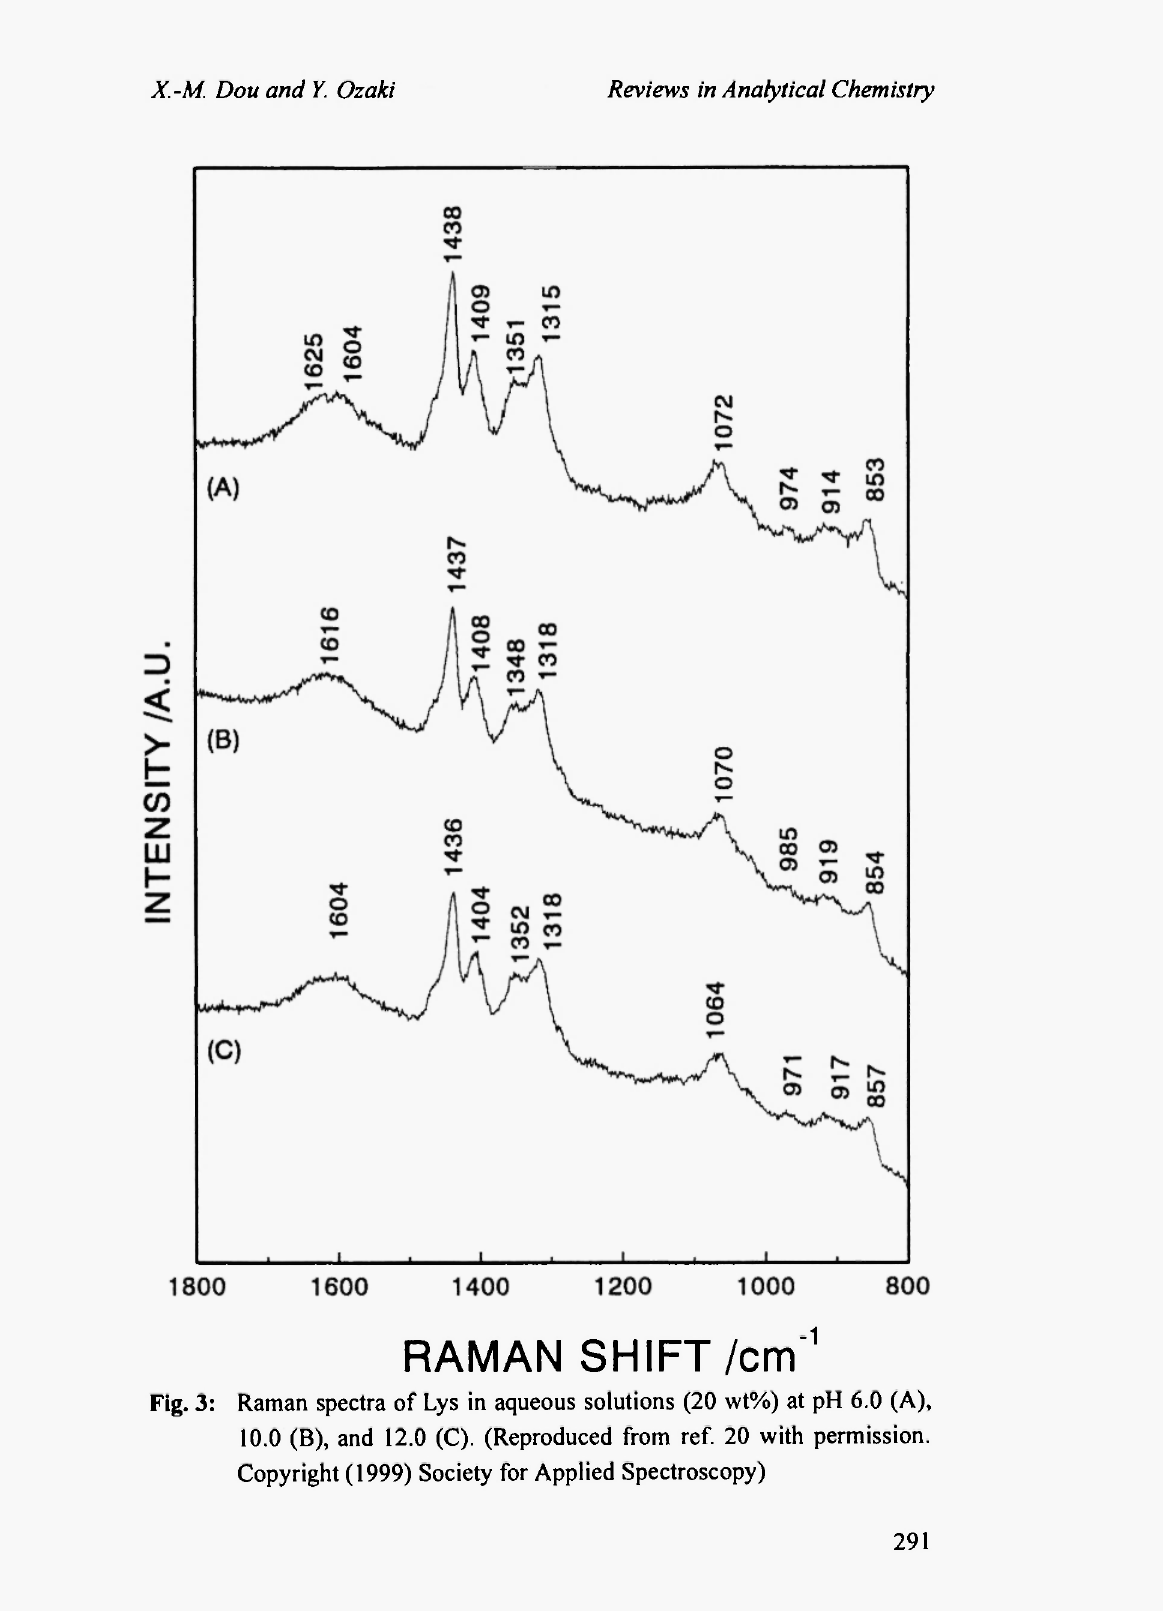
Fig. 3: Raman spectra of Lys in aqueous solutions (20 wt%) at pH 6.0 (A), 10.0 (B), and 12.0 (C). (Reproduced from ref. 20 with